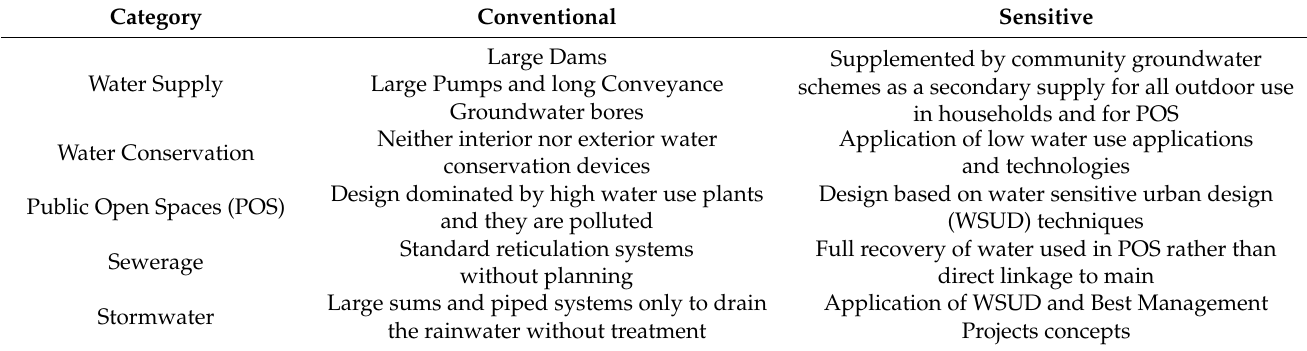
Table 2. Differences between elements of conventional and sustainable water management. Sensitive Large Dams Supplemented by community groundwater schemes as a secondary supply for all outdoor use in households and for